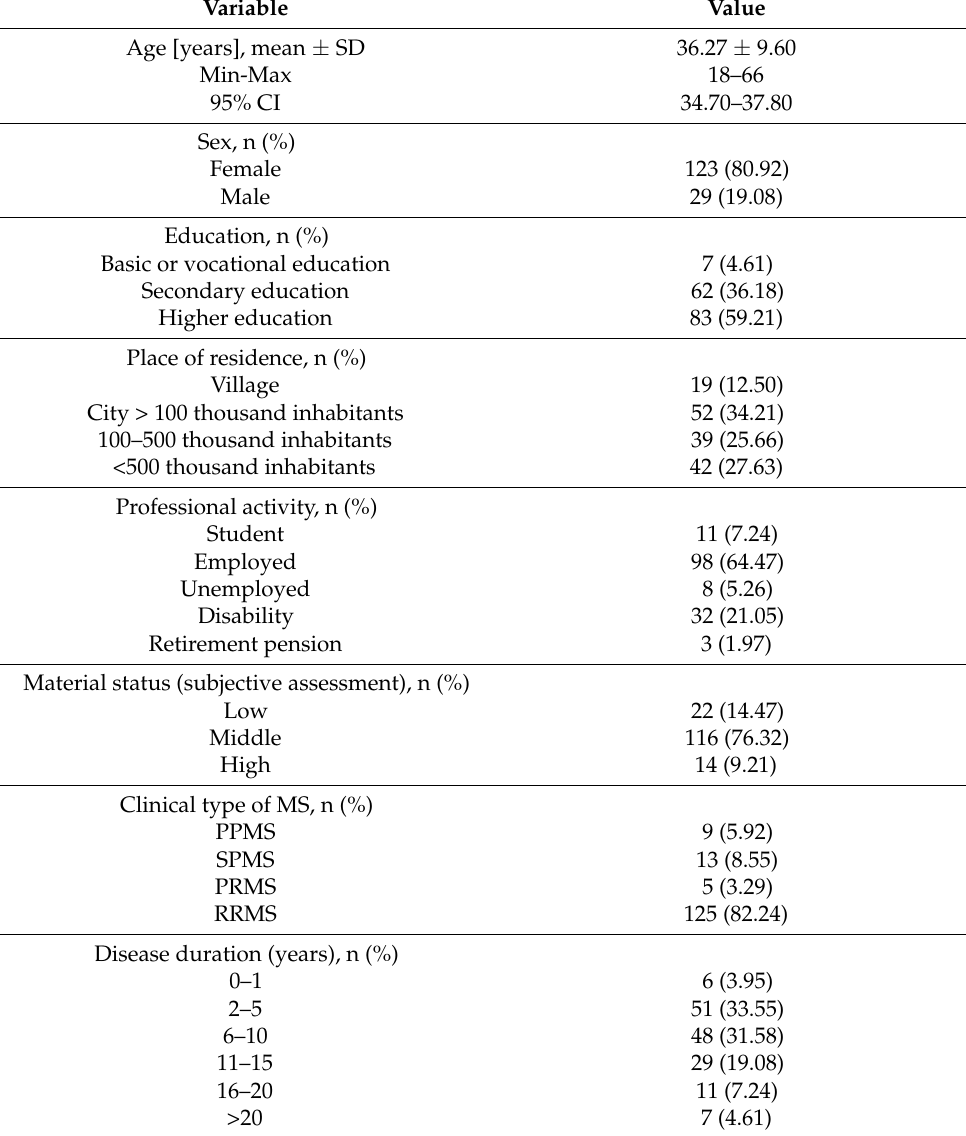
Table 1. Characteristics of the study group.